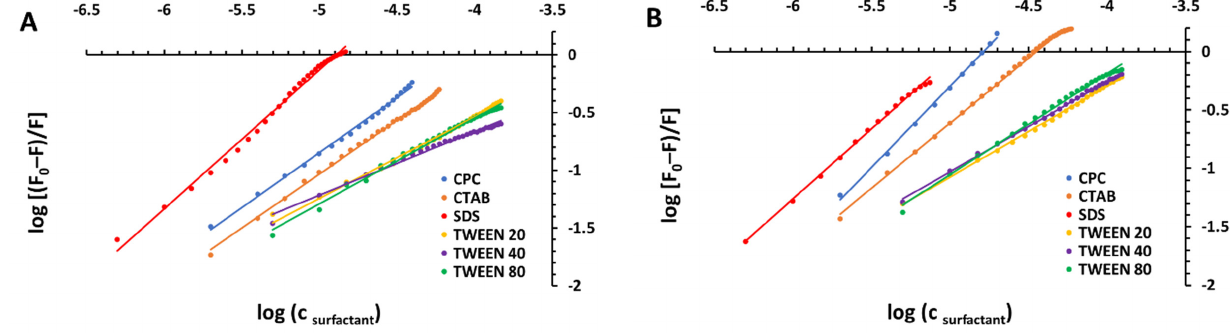
Figure 4. Modified Stern–Volmer plots for the steady-state fluorescence quenching of BSA by different